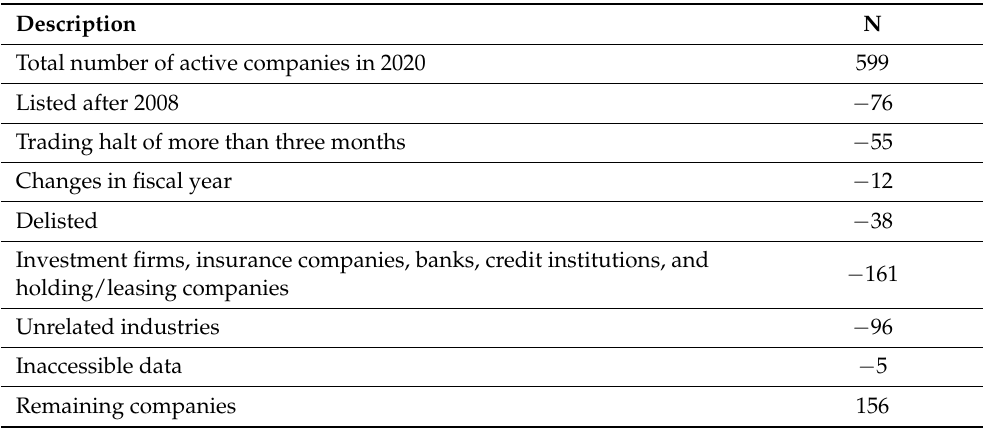
Table 1. Screening